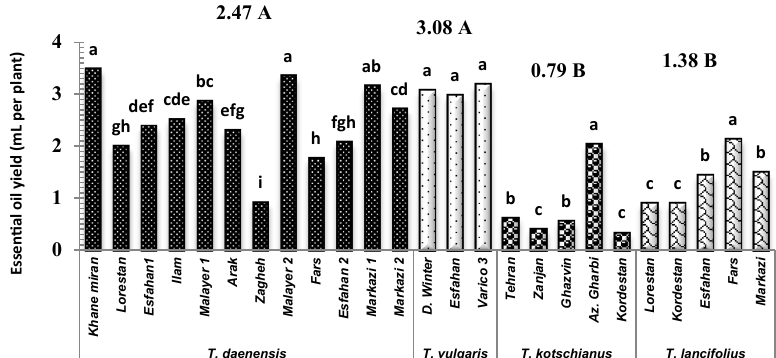
Fig. 3: Mean essential oil yield in different Thymus ecotypes and species